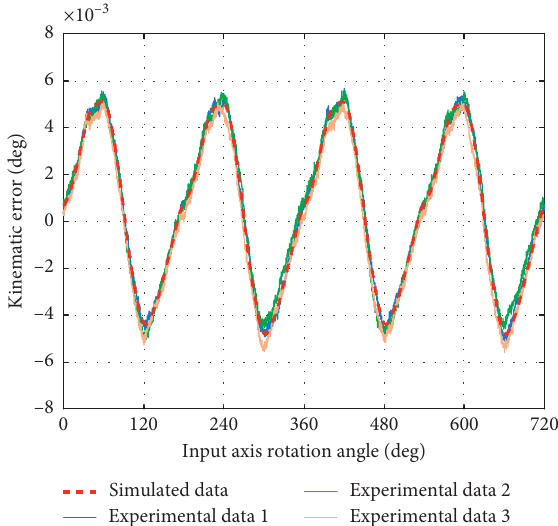
Figure 8: Measured kinematic error and simulation results of the Fourier series method.